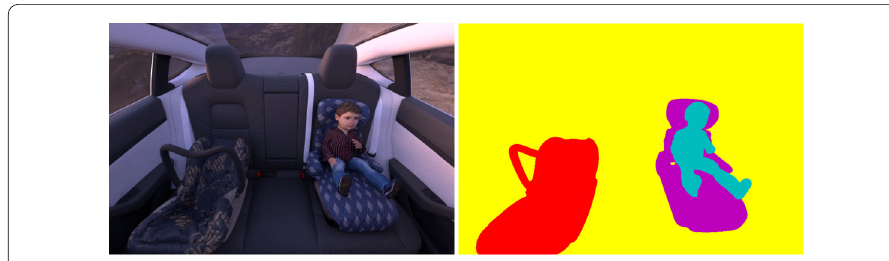
Figure 9 An RGB image (left) and the corresponding ground truth instance segmentation mask (right) of the SVIRO dataset. Source: